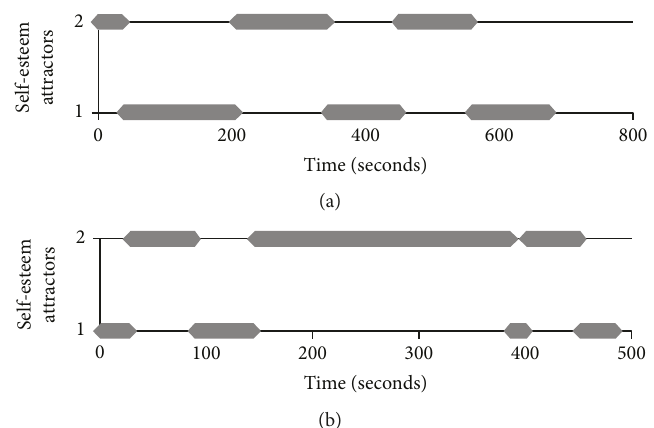
Figure 5: Empirical examples of self-esteem attractor time series across the dyadic interaction for two participants (a and b). The grey bars indicate the duration of time (i.e., seconds) that the self-esteem attractors (1 and 2) are expressed.